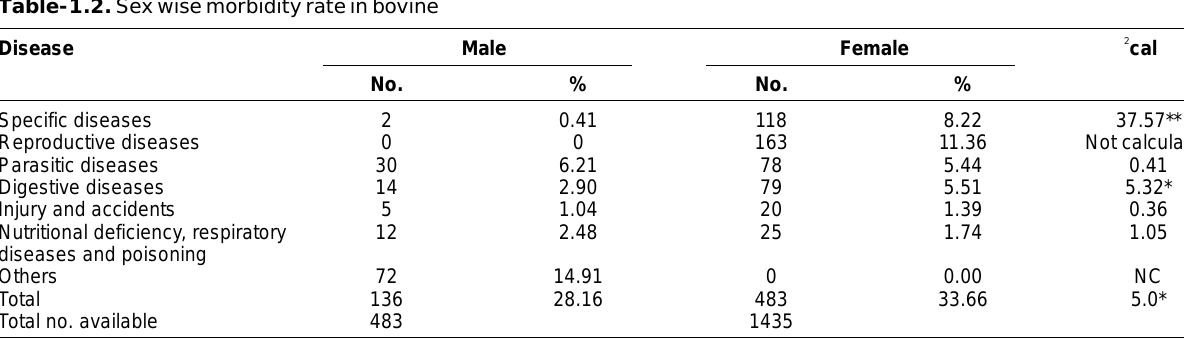
Table-1.2. Sex wise morbidity rate in bovine Disease